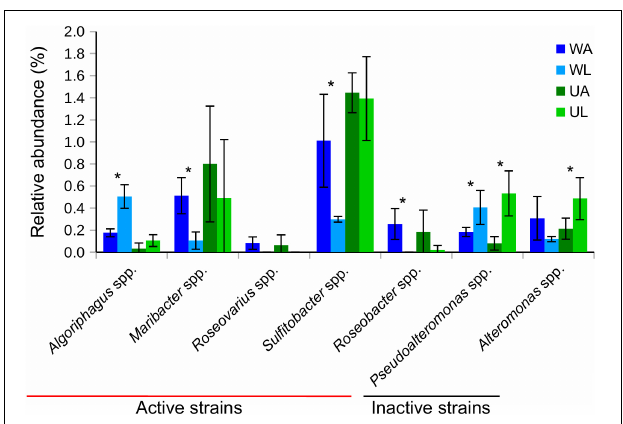
FIGURE 7 | Bar chart shows relative abundances (in %) of 16S rRNA gene reads of taxa, that were tested for morphogenetic activity in previous studies (see the section “Materials and Methods”), associated with Ulva tissue (green) and in water (blue) samples. Bacterial strains that possess morphogenetic activity in bioassay were defined as “active strains,” otherwise as “inactive strains”. Values were Hellinger-transformed. Significant differences between the two compartments (aquaculture – dark color and lagoon – light color) are highlighted by an asterisk ( p -value ≤ 0.05). UA, Ulva collected from aquaculture tanks; UL, Ulva strains from coastal lagoon; WA, water from aquaculture; WL, water from coastal